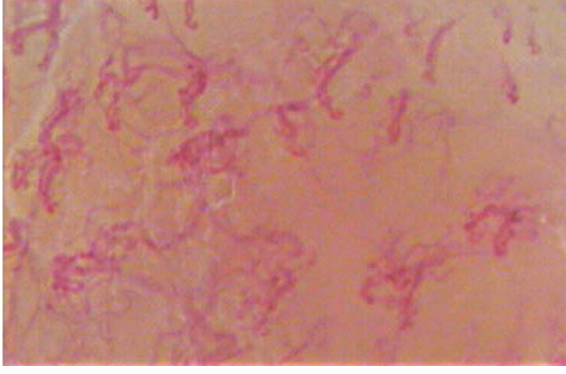
Figure 2. Oral microcirculation of patients affected by hypertension in treatment with antihypertensive drugs. Capillaroscopic picture which shows tangled capillaries that seem very tortuous, indistinguishable and overlapping. (magni fi cation 200X)